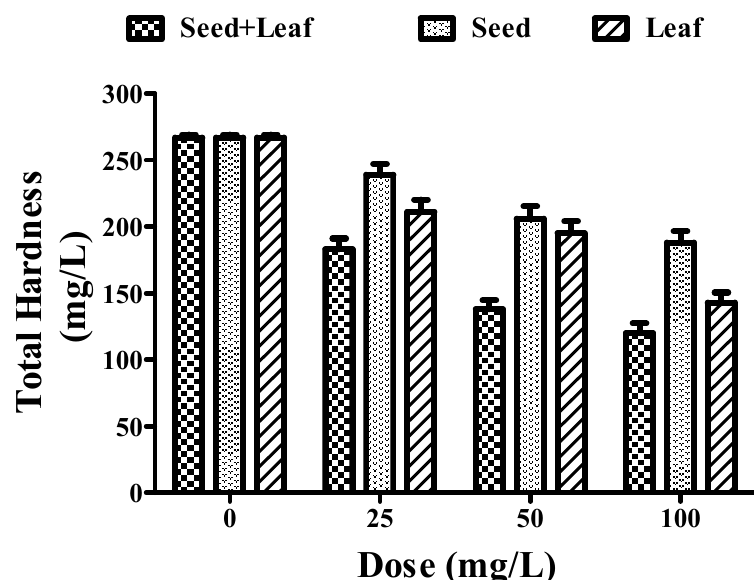
Figure 3. Comparative experimental analysis of combined (seed and leaf) and individual extracts of the Moringa oleifera plant on the hardness of groundwater at different doses (25–100 mg/L). All the experiments were done three times in triplicates and presented as mean ± SEM.